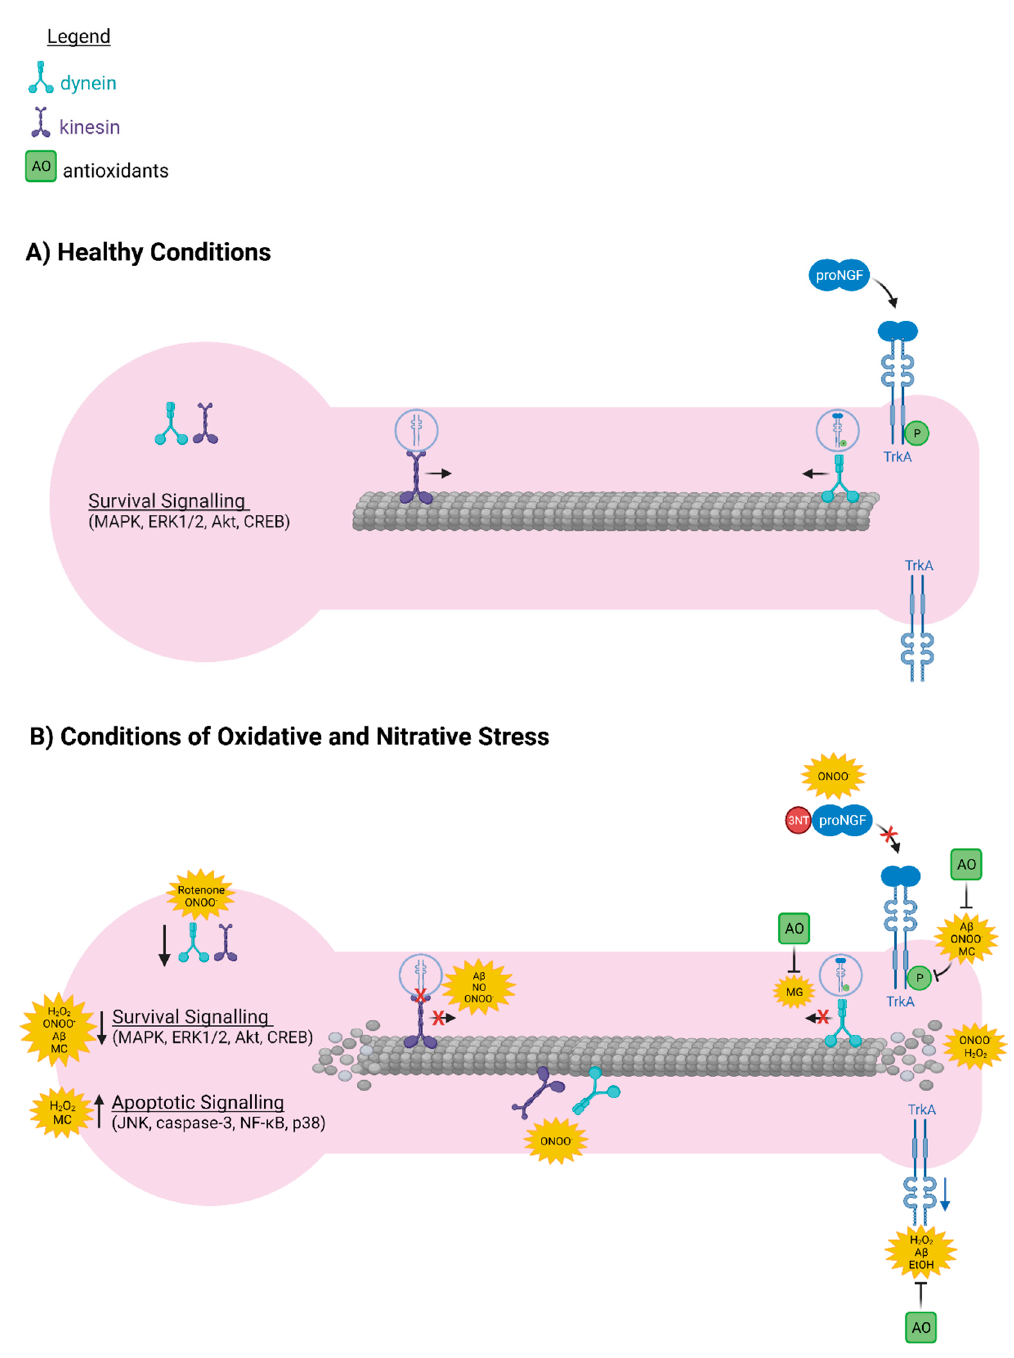
Figure 2. Oxidative and nitrative stress interfere with mechanisms of pro-nerve growth factor (proNGF) axonal transport. ( A ) Under healthy conditions, tropomyosin-related kinase A (TrkA) is expressed at axon terminals. Binding of proNGF induces TrkA autophosphorylation, internalization, and dynein-dependent retrograde transport. These events activate pro-survival signalling factors in the axon and at the cell body to maintain neuronal health. Kinesin motors transport somal TrkA receptors anterogradely to replenish and maintain axonal expression of TrkA. Kinesin and dynein molecular motors are expressed in the neuron and efficiently bind to microtubules to facilitate axonal transport of TrkA. ( B ) In conditions of oxidative and nitrative stress, such as in aging, Down’s syndrome (DS), and Alzheimer’s disease (AD), reactive oxygen and nitrogen species (ROS/RNS) decrease both protein and mRNA expression of TrkA. When nitrated, NGF is less efficient at activating TrkA and its downstream signalling factors, including mitogen-activated protein kinase (MAPK), phosphatidylinositol-3-kinase (PI3K), Akt, extracellular signal-regulated kinase 1/2 (ERK1/2), and cAMP response element- binding protein (CREB). ROS have the opposite effect on activation of signalling factors downstream of the pan-neurotrophin receptor, p75 NTR , including c-Jun N-terminal kinase (JNK), nuclear factor kappa B (NF- κ B), caspase-3, and